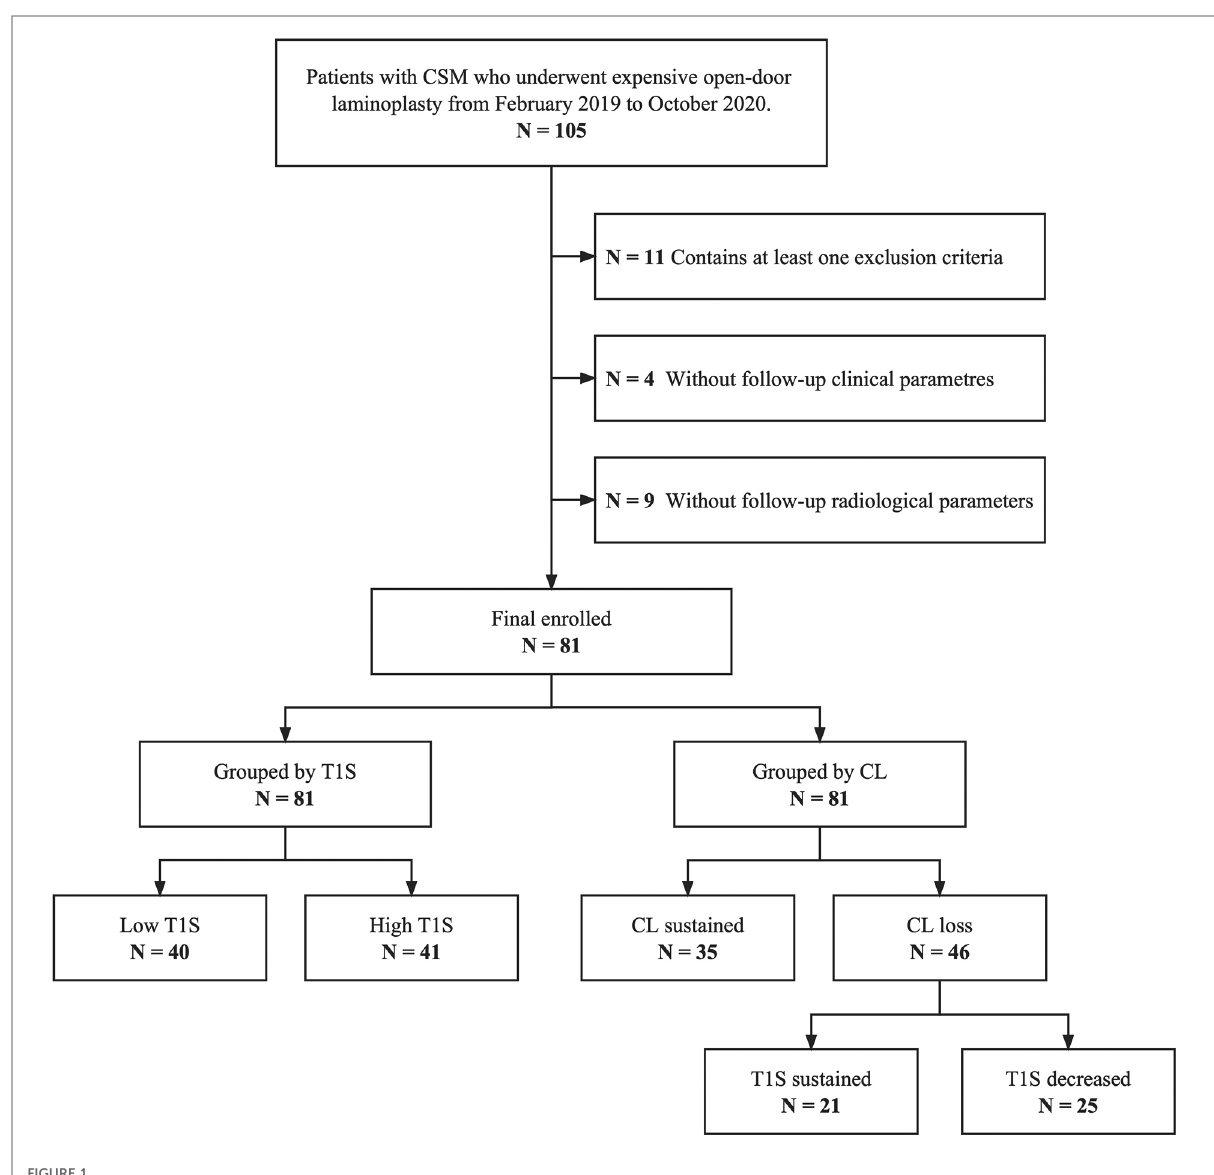
FIGURE 1 Flowchart of this